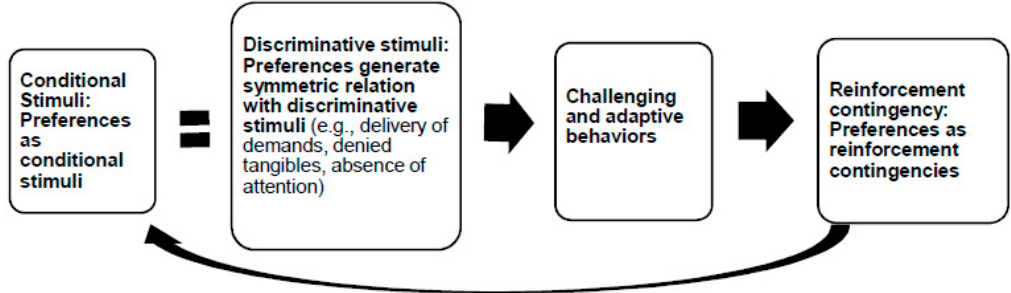
Figure 4. Multiple functions of high preferences in the behavioral four-term contingency: (1) high preferences serve as reinforcement contingencies; (2) high preferences serve as conditional stimuli as a result of the transference of their strong reinforcing value; (3) high preferences generate a symmetric relation between conditional stimuli and discriminative stim- uli.